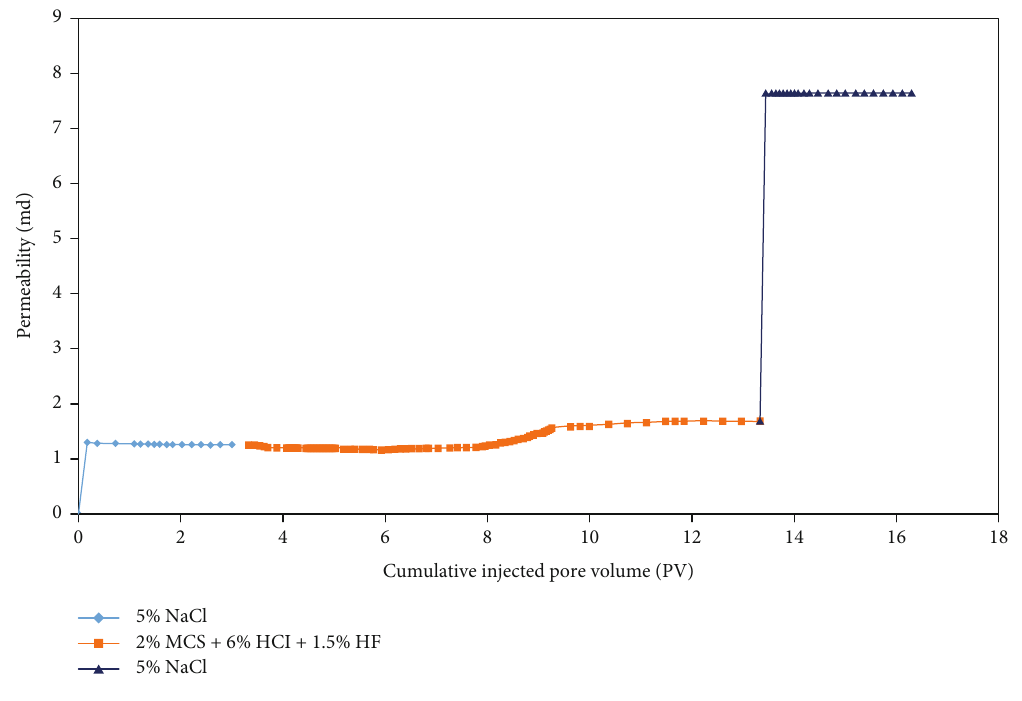
Figure 5: Permeability of A1 core fl ooding by composite mud